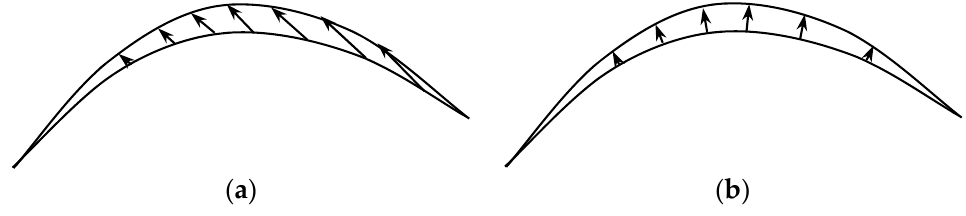
Figure 1. Two methods of point correspondence. ( a ) Approximation in a specified direction; ( b ) Approximation in the normal direction.